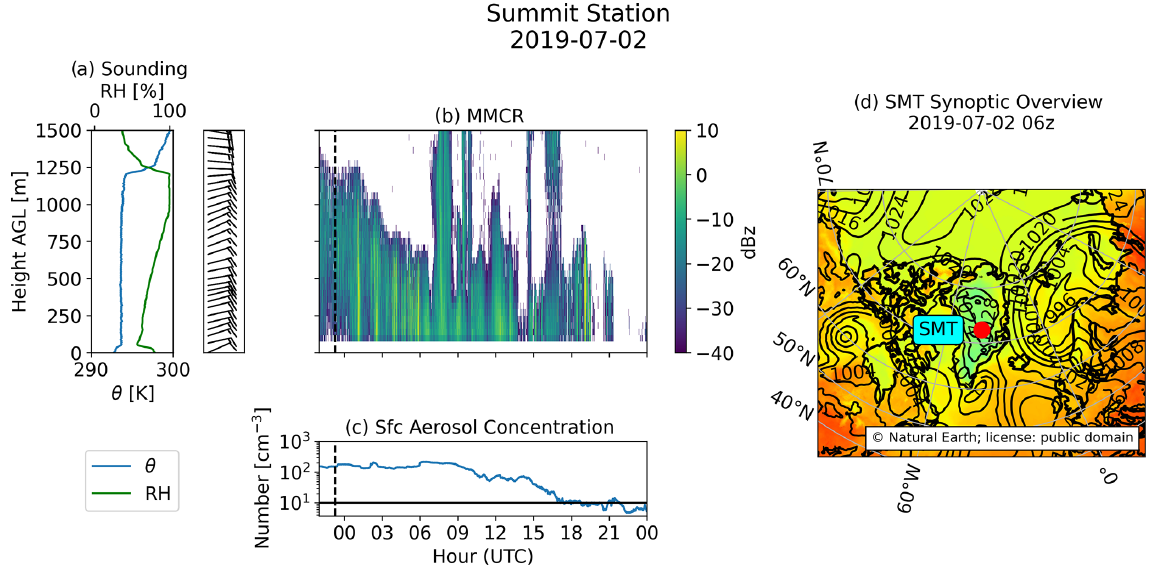
Figure 4. Same as Figs. 2 and 3 for the SMT